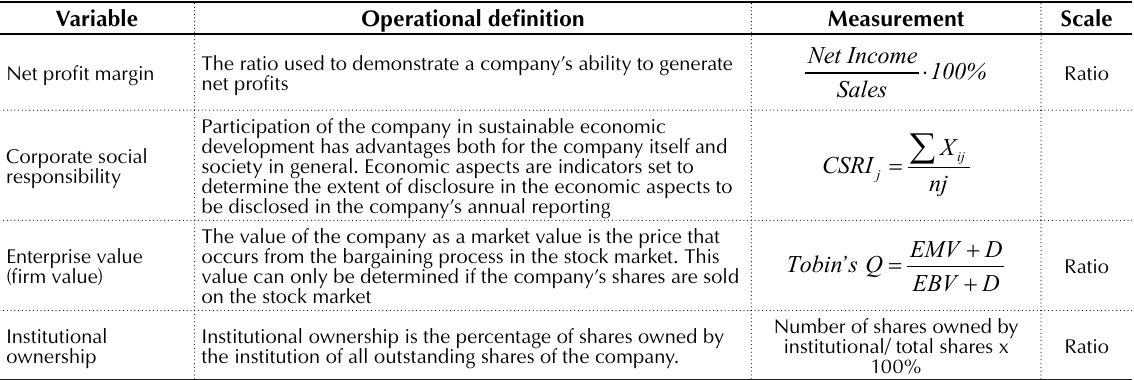
Table 1. Operational definition and variable measurement